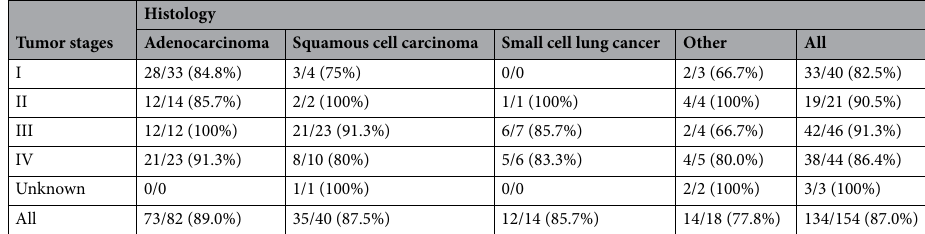
Table 3. Subtype analysis. Stage and histology-specific performance of the SHOX2 , RASSF1A and PTGER4 methylation biomarkers using plasma samples from patients with suspected lung cancer.